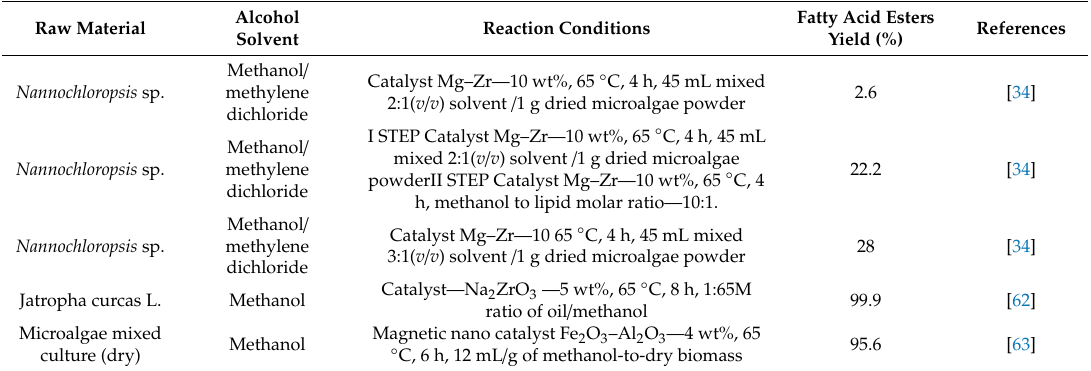
Table 4. Summary of studies on using heterogeneous catalysts for in situ transesterification. Raw